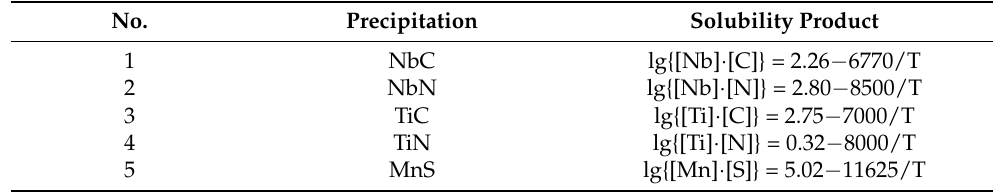
Figure 3. ( a ) Precipitation curves of the sulfide and nitride during the solidification process and ( b ) nanoparticle precipitation in welding thermal cycle. ( b ) nanoparticle precipitation in welding thermal cycle. Table 3. The solubility expressions for the precipitations [63,64].